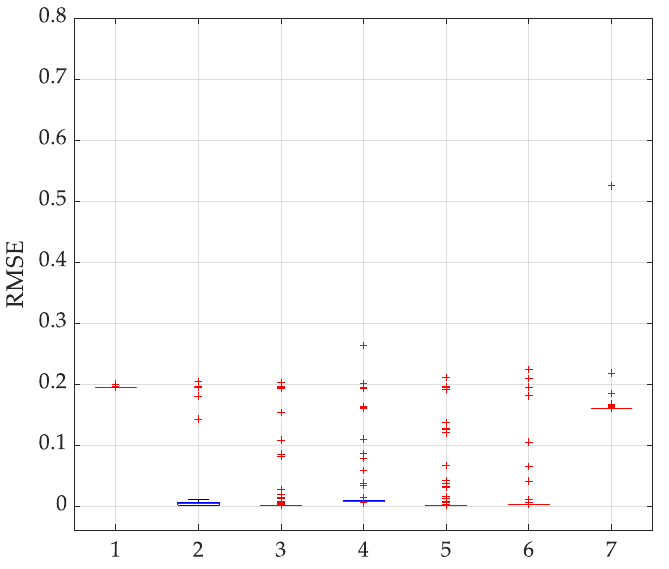
Figure 8. Boxplot graph of best RMSE in 30 runs for ( a ) single diose model ( b ) double-diode model ( c ) polycrystalline SS2018P PV module. Table 6. Ranking of the proposed WOAPSO and other compared algorithms on three PV models according to the Friedman test.